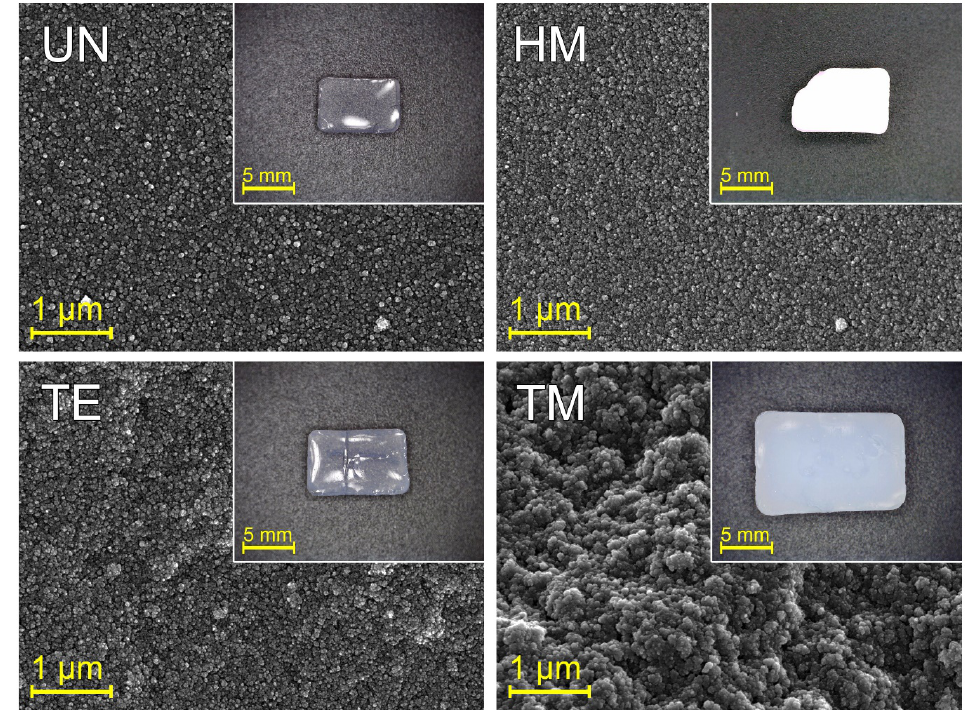
Figure 5. SEM images of the unmodified UN (top left), hexamethyldisilazane-modified HM (top right), triethylchlorosilane-modified TE (bottom left), and trimethylchlorosilane-modified TM samples (bottom right) after APD drying showed differences in their microscopic structure. While all displayed spherical particle morphologies, the size was bigger for the TM in comparison to the UN, the HM, and the TE samples. Additionally, inlets are shown with photographs of the respective monoliths, showing a decrease in size in the order of the TM, the TE, the HM, and the UN samples.